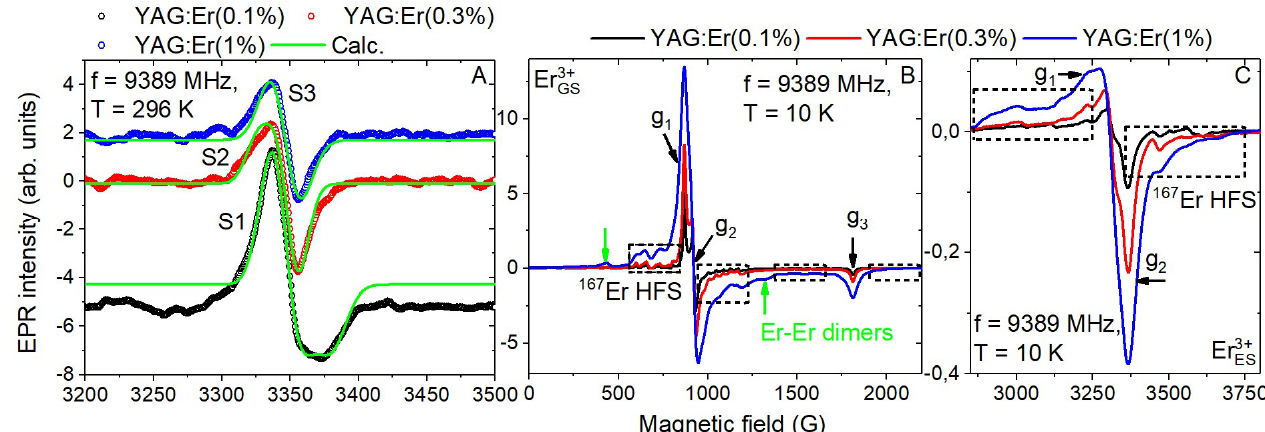
Figure 2. ( A ) Experimental EPR S1-3 signals measured in the YAG:Er (0.1, 0.3 and 1%) samples at 296 K shown along with the calculated ones. ( B ) Experimental EPR spectra of Er 3+ in the ground state (Er 3 + ) measured in the YAG:Er (0.1, 0.3 and 1%) samples at 10 K. g 1–3 , and arrows indicate the spectral position of the g tensor values contributions. Dashed oblongs stress hyperfine structure (HFS) due to 167 Er nucleus. Green vertical “up” and “down” arrows point out the doublets due to the Er–Er dimer creation. ( C ) Experimental EPR spectra of Er 3+ in the first excited state (Er 3 + ) measured in the YAG:Er (0.1, 0.3 and 1%) samples at 10 K. g 1,2 and arrows indicate the spectral position of the g tensor values contributions. Dashed oblongs stress HFS due to the 167 Er nucleus. This signal is different in different samples—S1 in YAG:Er (0.1%), S2 in YAG:Er (0.3%) and S3 in YAG:Er (1%) as shown in Figure 2A. Moreover, the signals intensity is